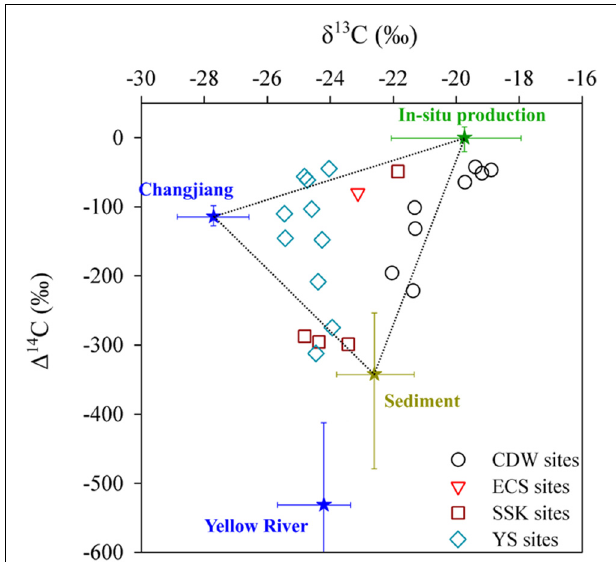
FIGURE 5 | Cross-plot of (cid:49) 14 C and δ 13 C values of POC. The endmember values of the Changjiang and the Yellow River are from Zhang et al. (2007) and Wang et al. (2012), respectively. The endmember values of surface sediment are from Bao et al. (2016). The endmember values of in situ production are from the (cid:49) 14 C, and fractionation-corrected δ 13 C values of DIC are observed in this region (Oh and Hwang, unpublished, 2021;